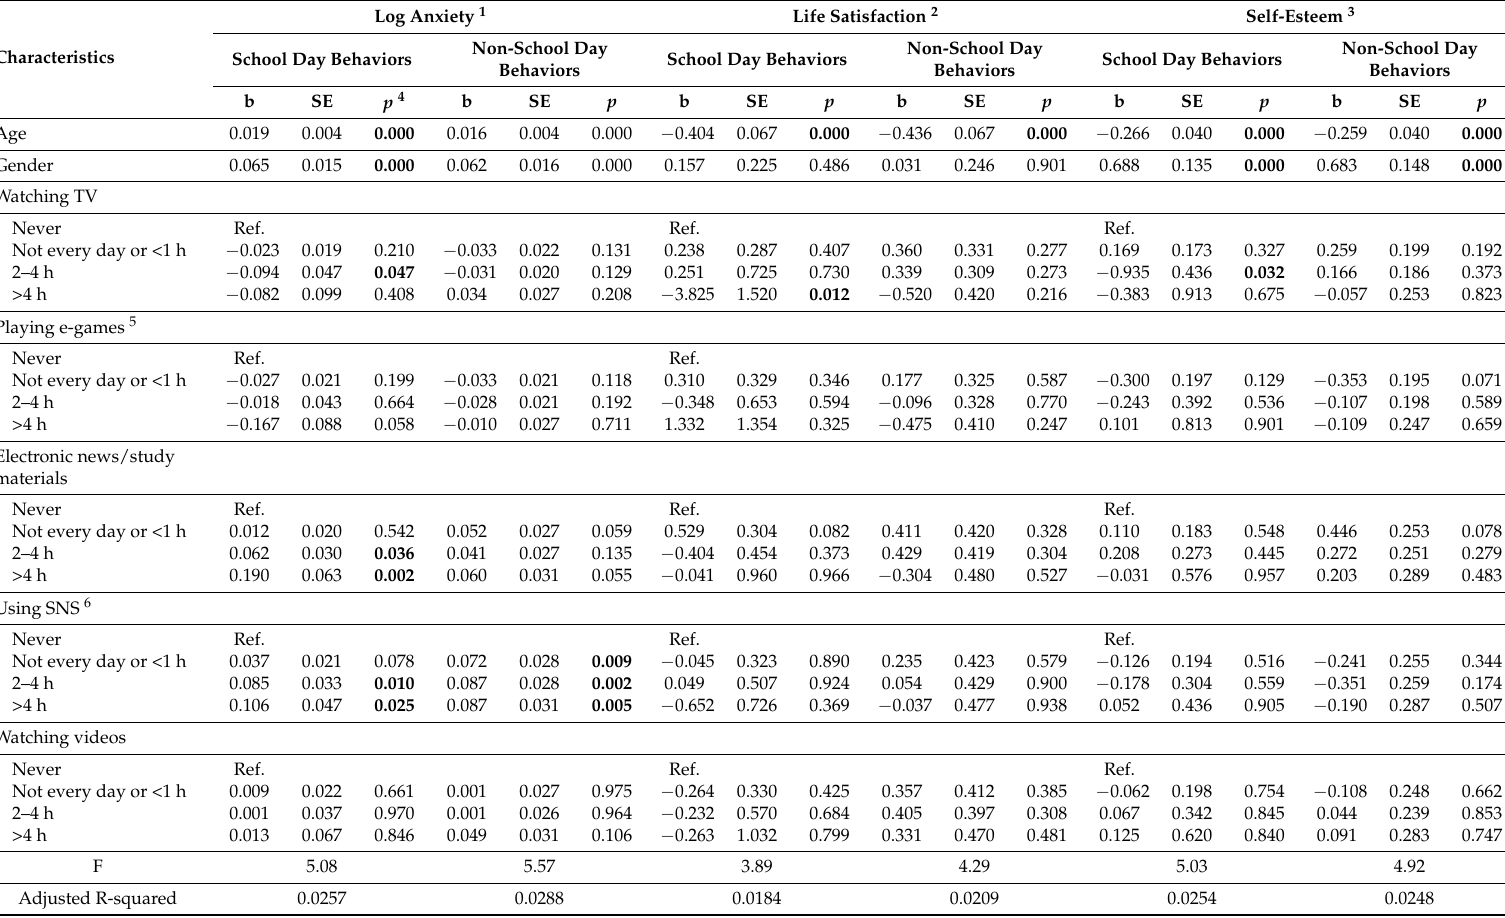
Table 5. The relation of anxiety, life satisfaction and self-esteem and screen time components ( n =